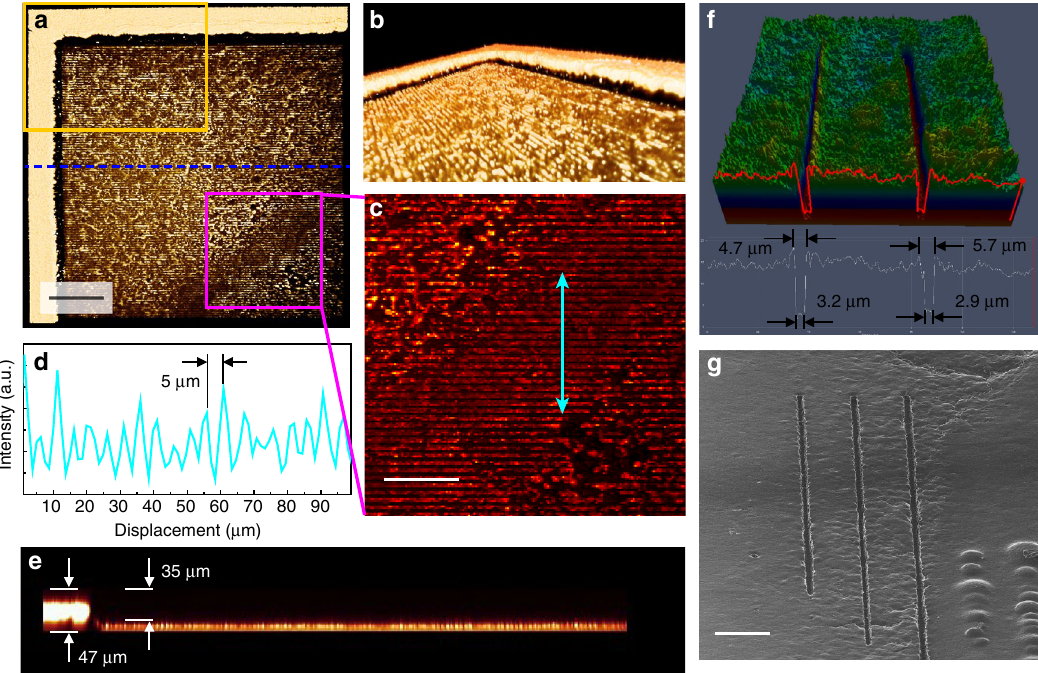
Fig. 6 Morphological changes of hippocampal tissue specimen after AP-nanoPALDI process. a – e Coherent anti-stokes Raman scattering (CARS) images taken with regards to the vibrational modes from 2750 to 2950cm − 1 after AP-nanoPALDI MS analysis; a top view, b side view of the orange rectangle in a , and c zoomed-in view of the magenta square in a . d The CARS intensity pro fi le along the double sided arrows in c , shows the length of one trench was very close to 5 µ m. e Cross-sectional view across the horizontally drawn blue dotted line in a . f Line patterns pro fi le by 3D confocal imaging and, g helium ion microscopy (HIM) imaging of individual line patterns ablated by AP-nanoPALDI. All the images were taken after the hippocampal tissue was dried. Scale bars, a 100 µ m, c 50 µ m, and g 50 μ